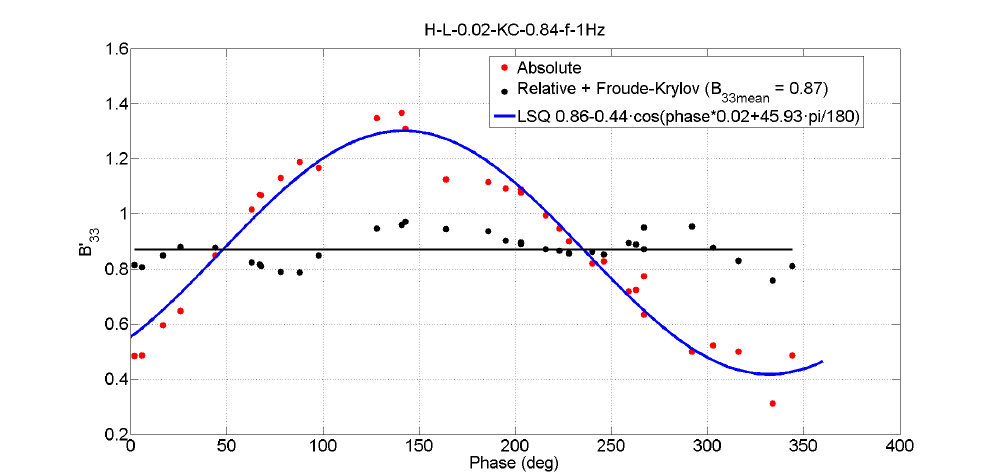
Figure 7. Damping coefficient vs. phase angle for H / L = 0.02, KC =